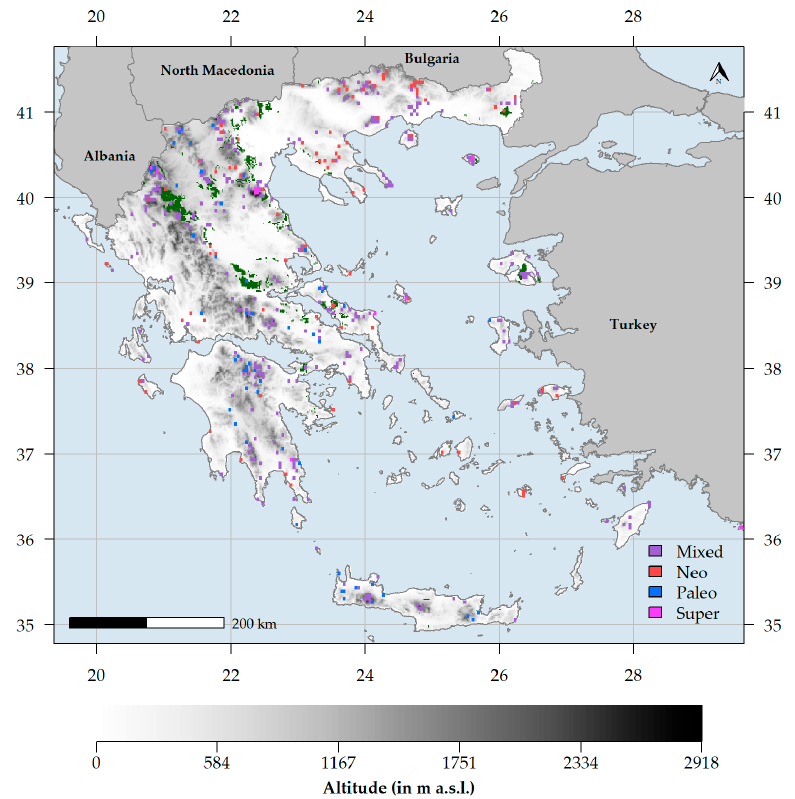
Figure 7. Map of significant phylogenetic endemism (PE) identified by the categorical analysis of neo- and paleo-endemism (CANAPE) analysis for the endemic plant taxa occurring in Greece. Dark green colouring indicates the areas where ultramafic rocks occur in Greece.